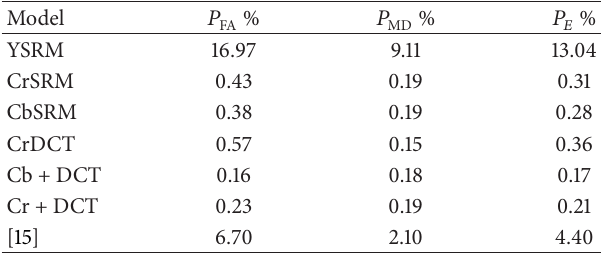
Table 7: Detection results on the CASIA V2